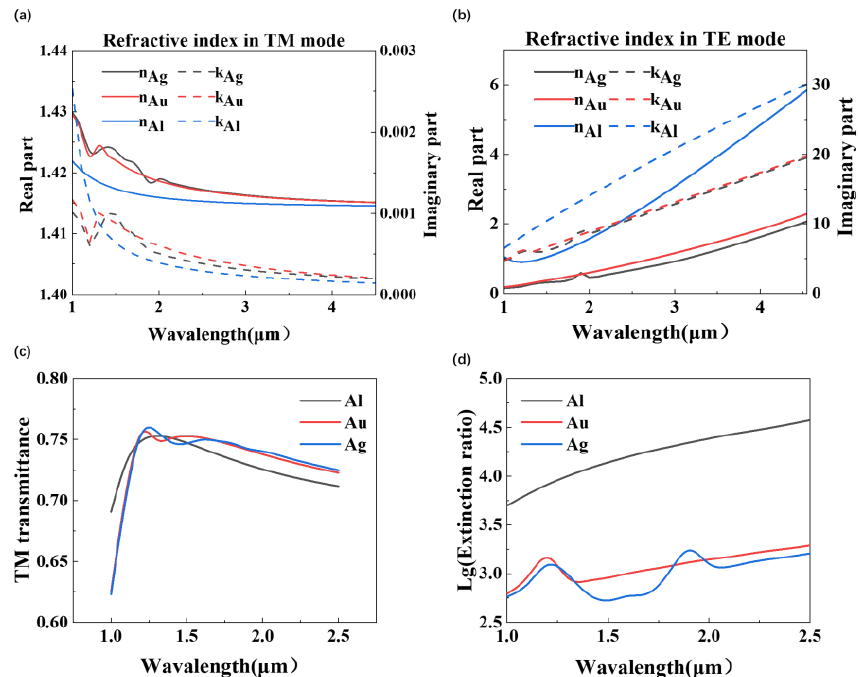
Figure 1. ( a ) The refractive index of gratings of different materials under TM polarization, where the solid line is the real part of the refractive index and the dotted line is the imaginary part. ( b ) The refractive index of gratings of different materials under TE polarization, where the solid line is the real part of the refractive index and the dotted line is the imaginary part. ( c ) The TM transmittance of different metal gratings. ( d ) The extinction ratio of different metal gratings (logarithmic scale).